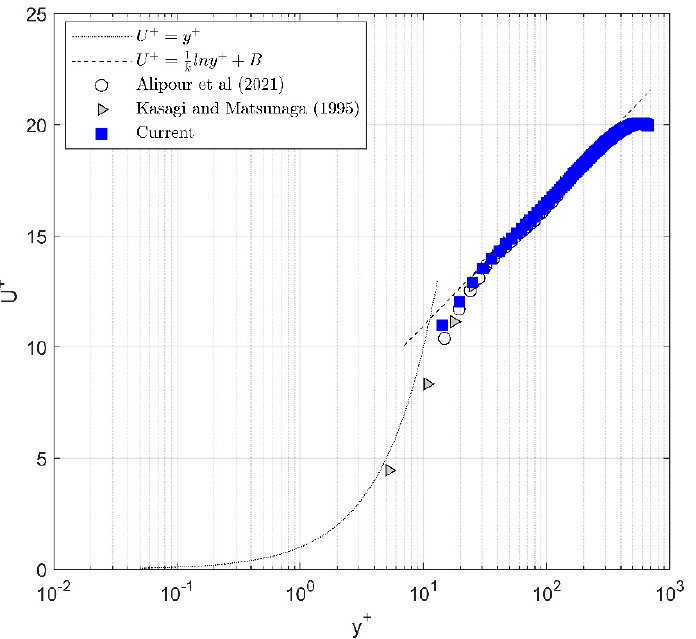
Figure 4. Clear-water reference case. Average stream-wise profile in wall coordinates compared to logarithmic law of the wall ( κ = 0.41 and B = 5.2) and reference data from Alipour et al. (2021) and Kasagi and Matsunaga (1995).